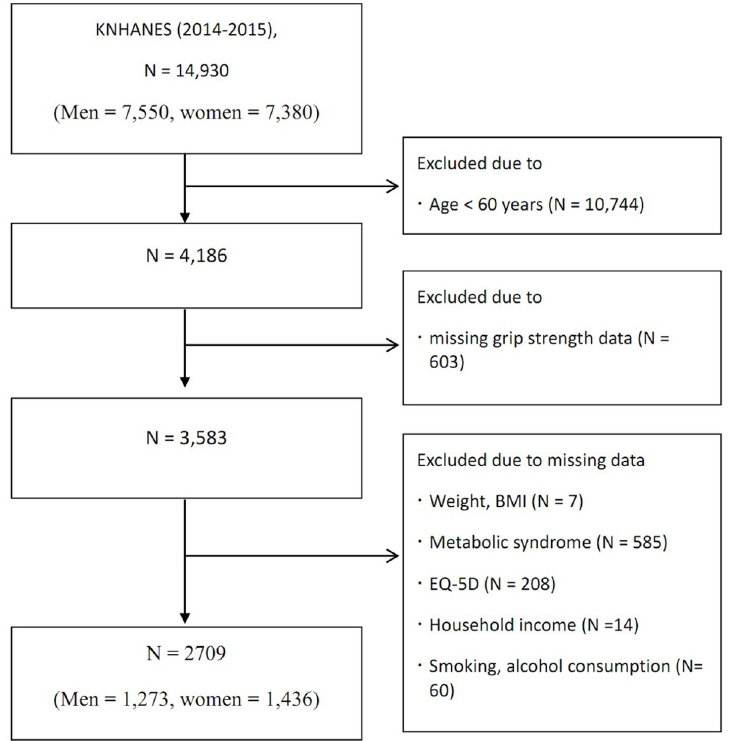
Fig 1. Flow diagram of study participants. KNHANES, Korean National Health and Nutrition Examination Survey; BMI, body mass index; EQ-5D, EuroQol Five-dimension.